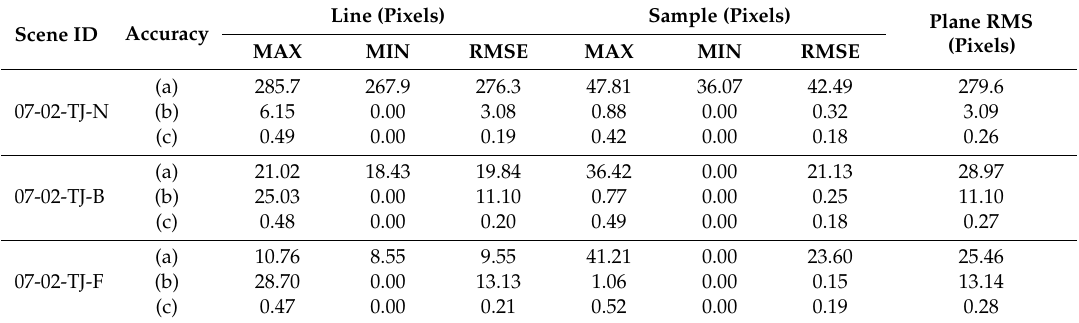
Figure 8. ( a – c ) Distribution of ground control points (GCPs) in 07-02-TJ-N, 07-02-TJ-B, and 07-02-TJ-F. The dynamic exterior orientation parameters Mat eI and interior orientation parameters a i , b j ( i , j ≤ 5) in Equation (4) were solved successively by using the GCPs. The calibration accuracy is shown in Table 4. Table 4. Geometric positioning accuracy before and after exterior and interior